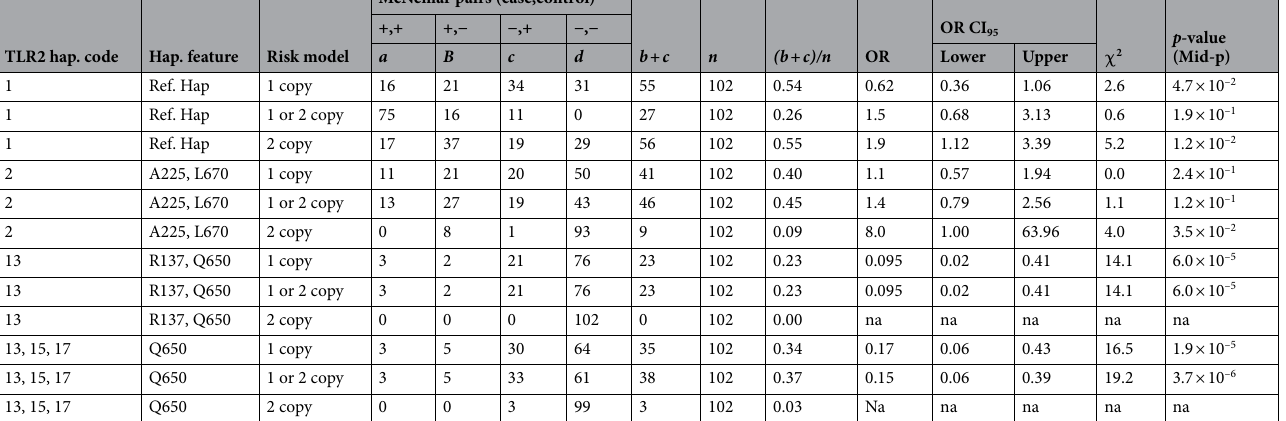
Table 3. Association of propeptide haplotypes encoded by TLR2 with OJD. “+,+”, “+,−”, “−,+”, and “−,−”; indicate risk factor status within case, control pair; a, b, c , and d , are McNemar’s quadrants (Methods Table 4). CI 95 95% confidence interval; Hap haplotype; Ref reference; n number of total pairs; OR odds ratio; χ 2 the McNemar test statistic with continuity